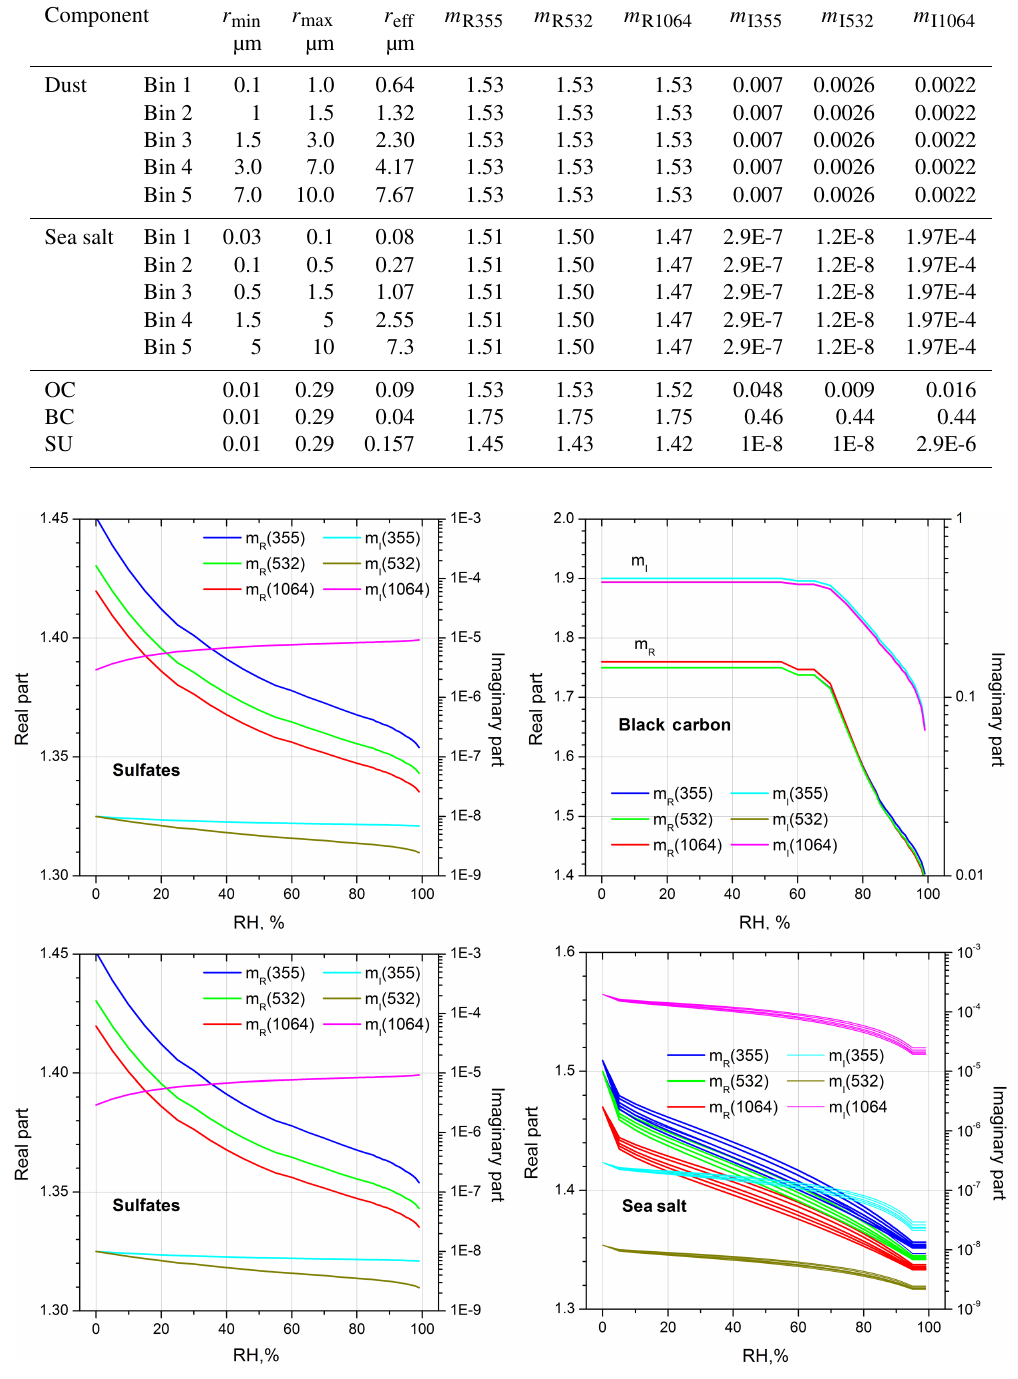
Figure A2. Dependence of the real and imaginary part of the refractive index of organic carbon (OC), black carbon (BC), sulfates (SU), and sea salt (SS) on relative humidity (RH) used in the MERRA-2 model. For the sea salt the results are given for five size bins from Table 1. Both m R and m I decrease with bin number